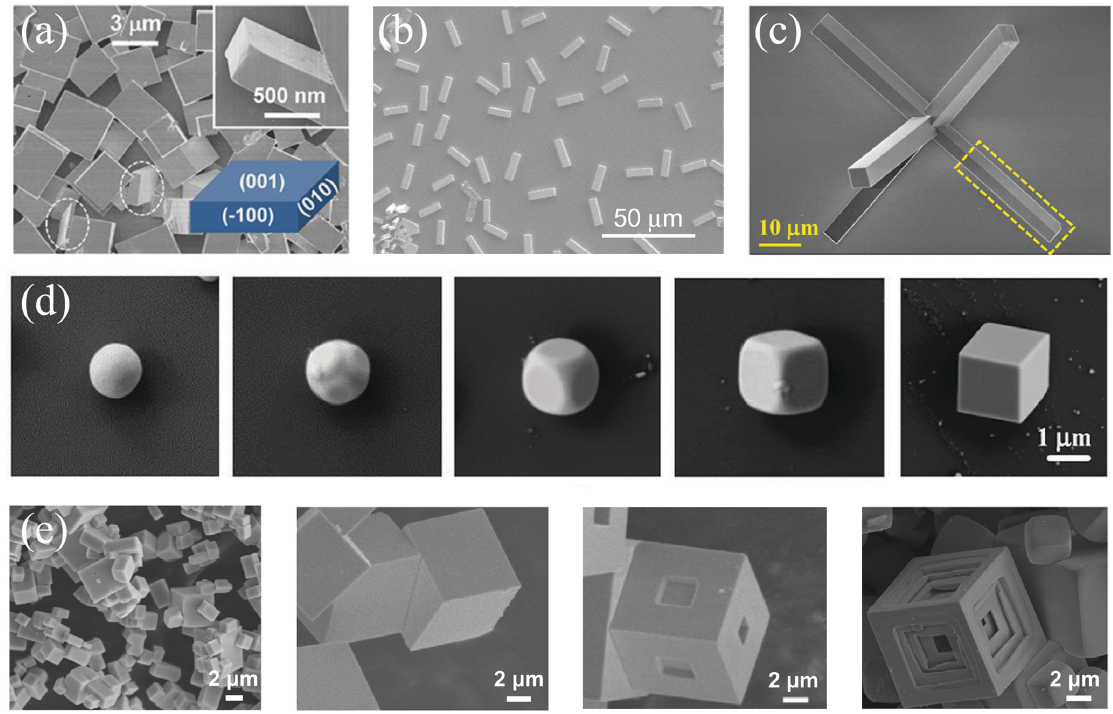
Figure 8. SEM images of ( a ) parallelepiped microcrystals of bromide perovskite MAPbBr 3 at low magnification and high magnification (top inset). The circled regions indicate the thickness of square MDs. The right bottom inset shows a cartoon of a square MD. Adapted with permission from [53]. John Wiley and Sons, 2015. ( b ) CsPbBr 3 microrod. Adapted with permission from [54]. John Wiley and Sons, 2015. ( c ) MAPbBr 3 branched microrod. Adapted with permission from [55]. Royal Society of Chemistry, 2017. ( d ) CsPbBr 3 microcubes at different growth stages with increasing temperature. Adapted with permission from [56]. Royal Society of Chemistry, 2018. ( e ) MAPbBr 3 cuboids at different reaction times. Adapted with permission from [57]. Elsevier,